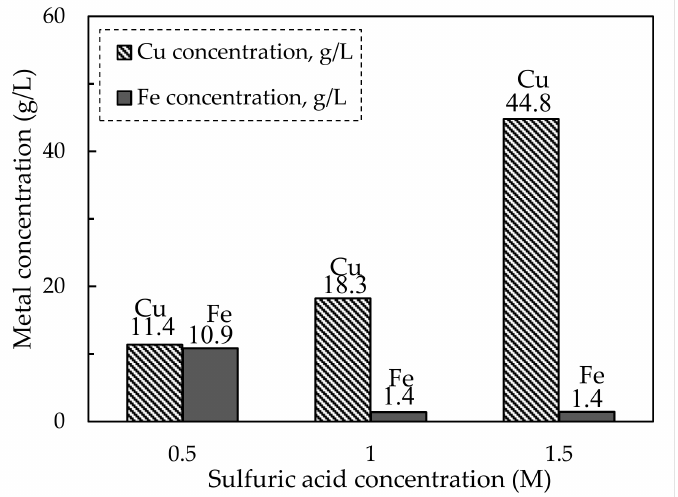
Figure 9. The metal concentration in stripped solution as a function of sulfuric acid concentration. (Conditions: organic/aqueous phase ratio 5, agitation speed 600 rpm, and contact time 15